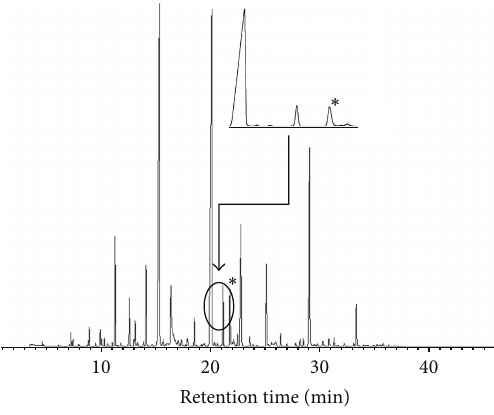
Figure 4: GC-MS chromatogram of A. judaica oil. ( ∗ ) peak appeared as single peak even in diluted samples.